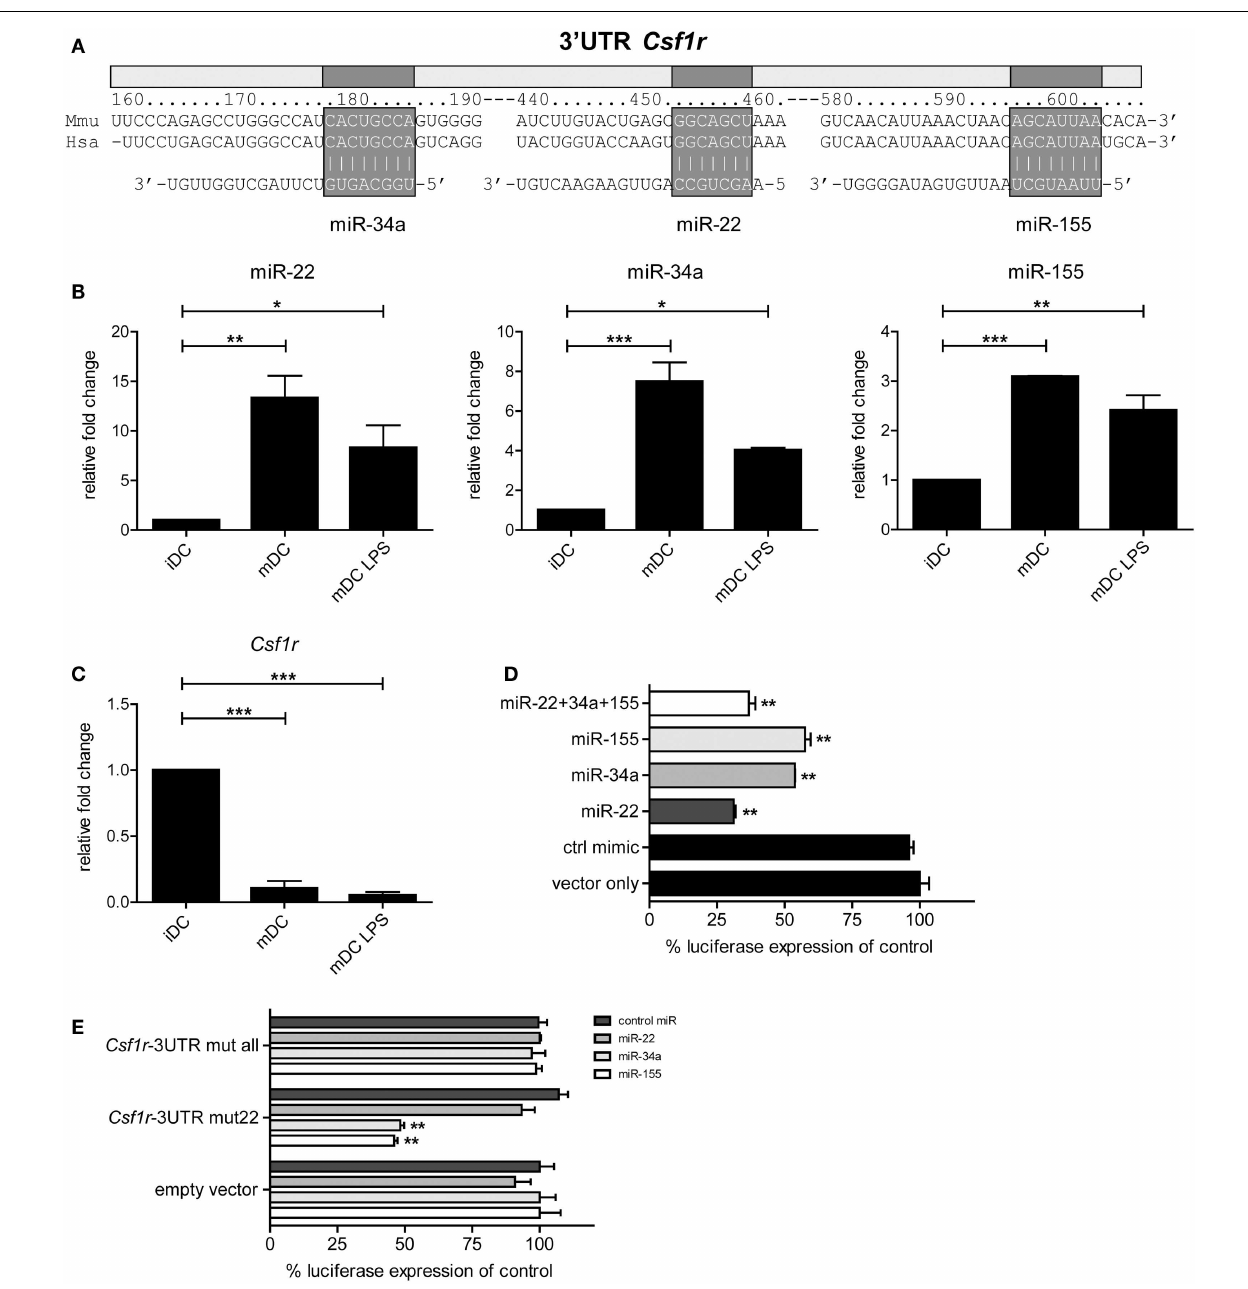
FIGURE 2 | Csf1r is a verified target of miR-22, -34a, and -155 . (A) Schematic representation of the Csf1r- 3 (cid:48) UTR showing the predicted conserved microRNA binding sites for miR-22, -34a, and -155. Expression of (B) miR-22, -34a, and -155 and (C) Csf1r mRNA in different sorted DC populations that were used for microRNA profiling, assessed using qPCR. Relative expression changes were calculated using the 2 - ∆∆ Ct method and expressed as fold change over tubulin controls. Data are expressed as means ± SEM from three experiments; * p < 0.05, ** p < 0.01, *** p < 0.001 compared with iDC control. (D,E) The full-length Csf1r- 3 (cid:48) UTR was cloned downstream a Renilla luciferase (RLuc) gene (psiCHECK-2 vector). HEK293T cells were transiently transfected with the psiCHECK-2 reporter vector